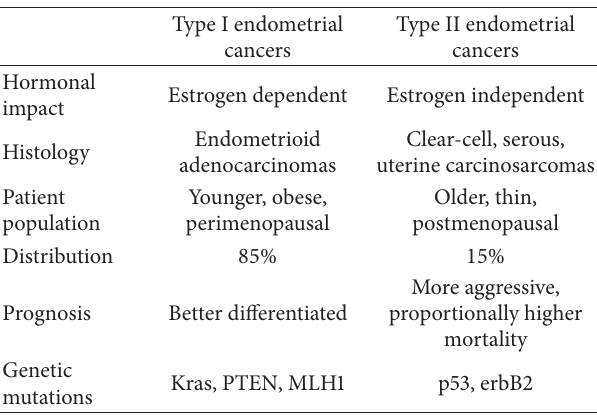
Table 2: Type I and II endometrial